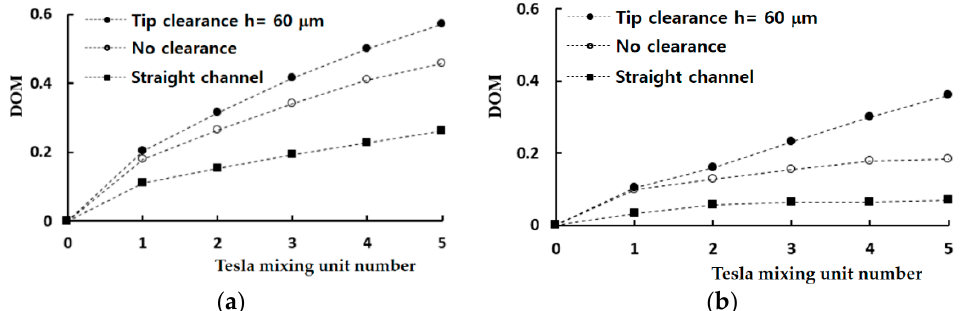
Figure 8. Comparison of mixing evolution in the axial direction: ( a ) Re = 0.1 and ( b ) Re = 1.